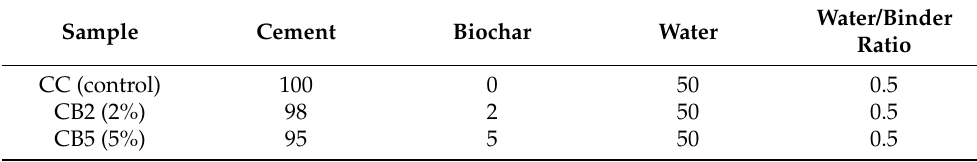
Table 2. Mix proportion of samples (mass %).